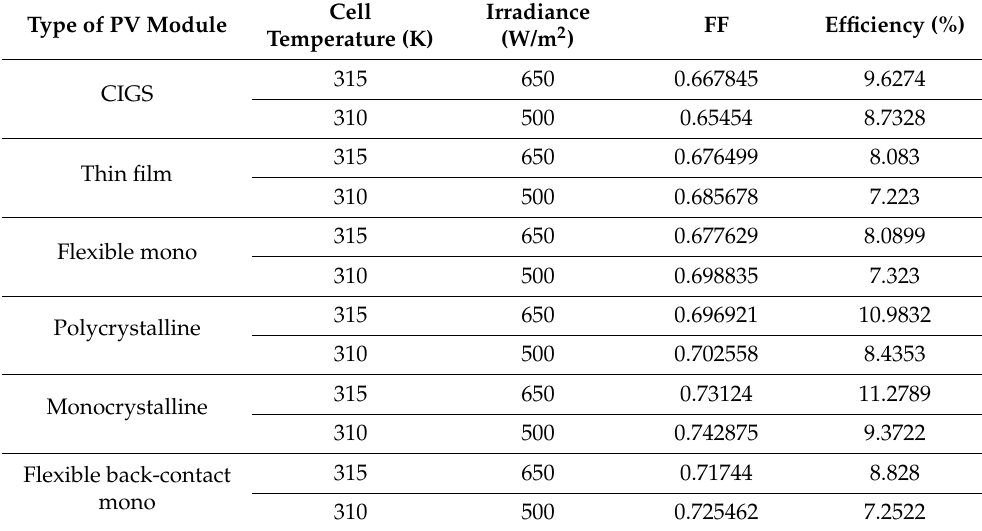
Table 3. FF and efficiency for the six PV modules under the same test conditions.